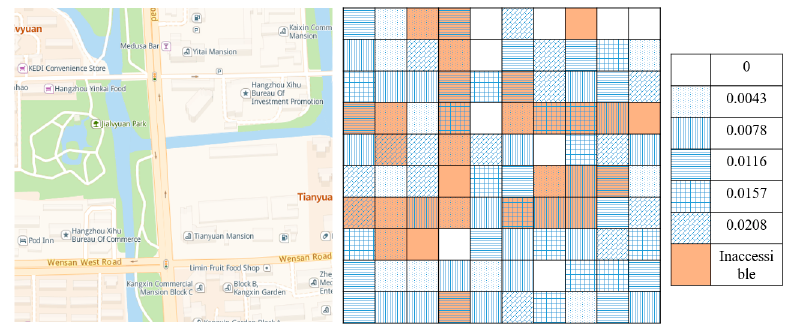
Figure 5. The simulation area and the corresponding service request probability distribution. The simulation environment is Windows10, with 8 GB memory and AMD Ryzen 5 3550 H